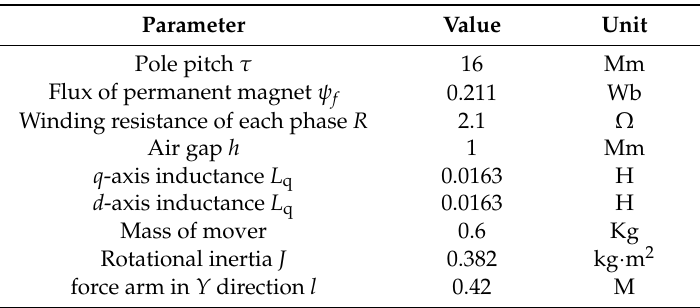
Table 1. Electromagnetic model